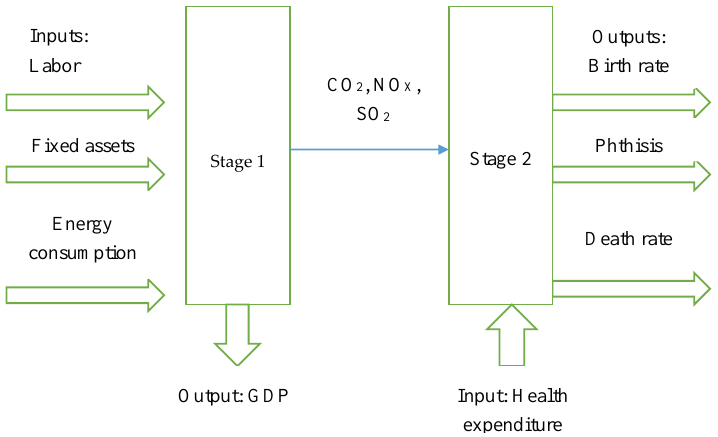
Figure 1. Process of inputs and outputs.